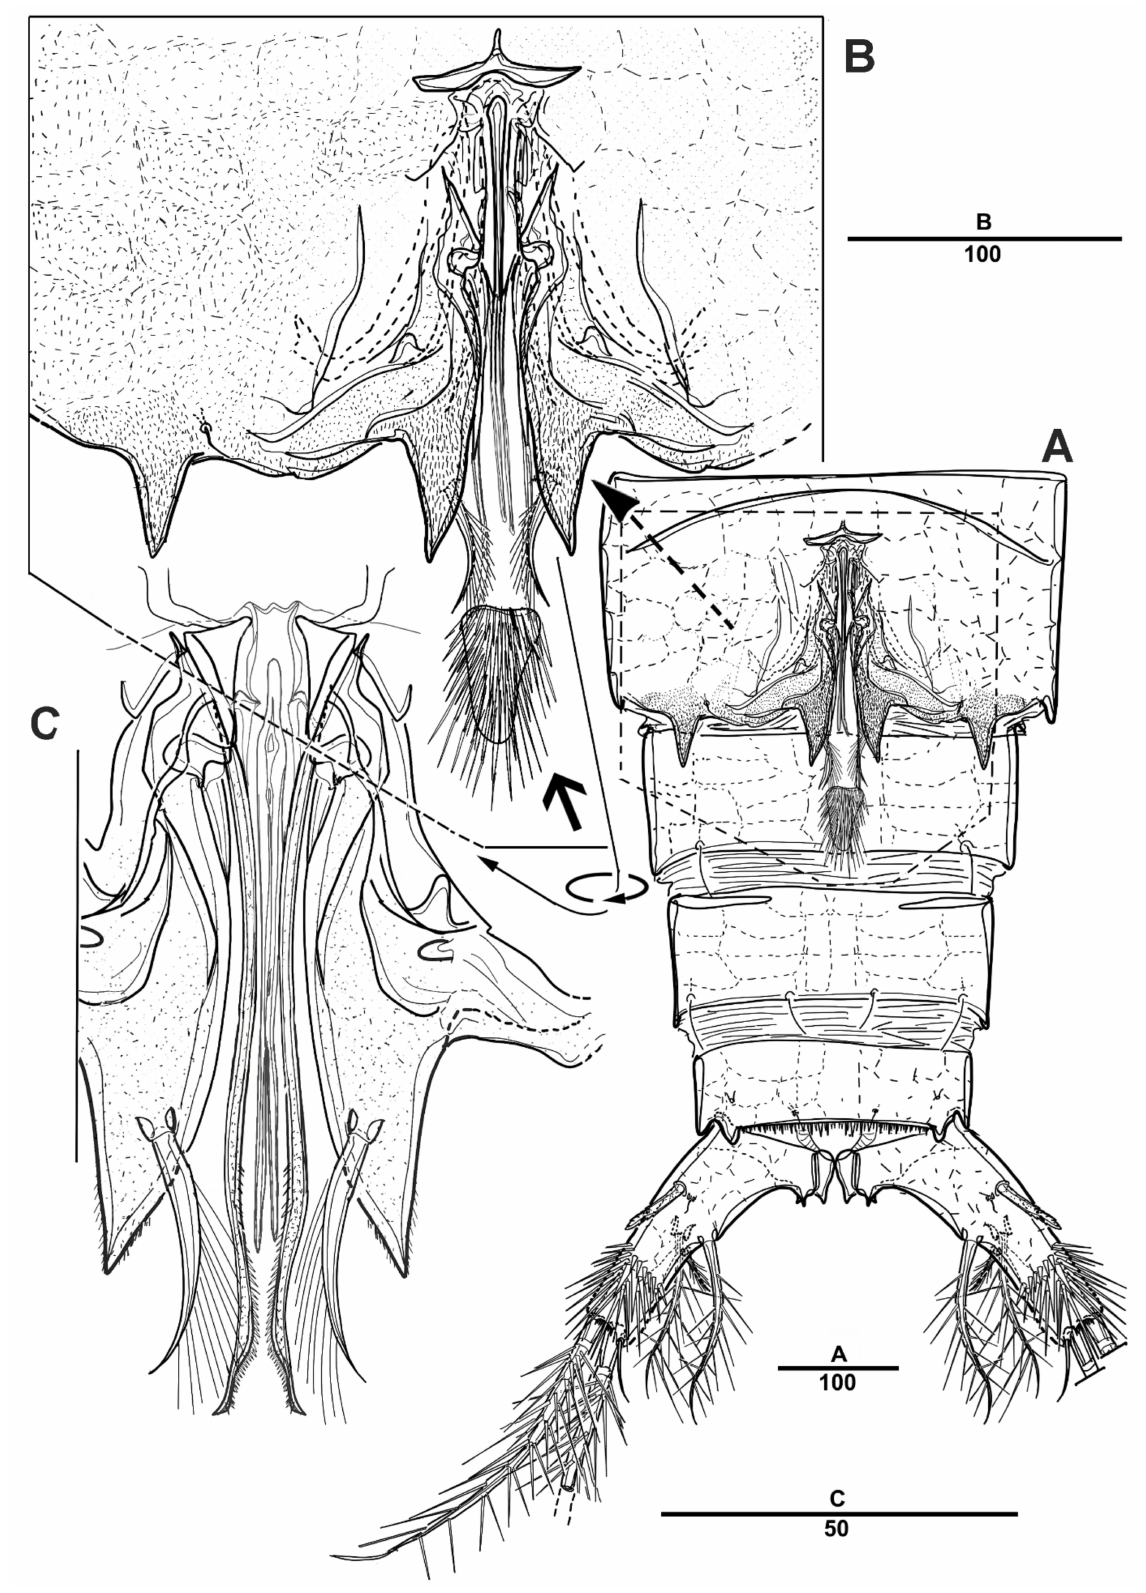
Figure 11. Scottolana daecheonensis sp. nov. paratype male: ( A ) urosome, ventral; ( B ) genital field, ventral (patch of dense spinules arrowed); ( C ) detail of P6, dorsal. Scale bars in µ